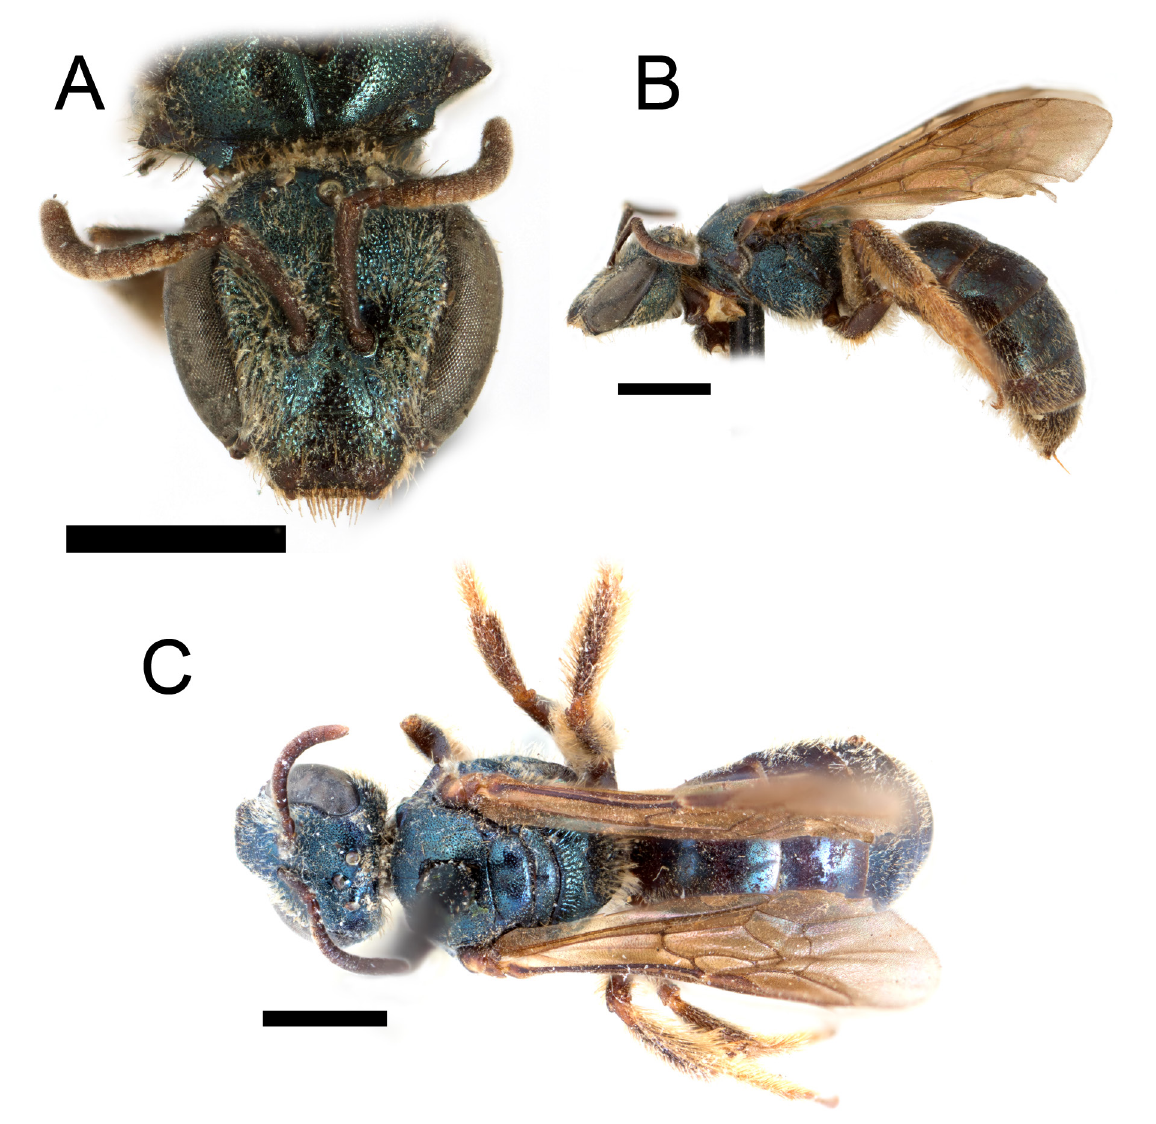
Fig. 15. Lasioglossum ferrerii (Baker, 1906), ♀. A . Face. B . Lateral habitus. C . Dorsal habitus. Scale bars = 1